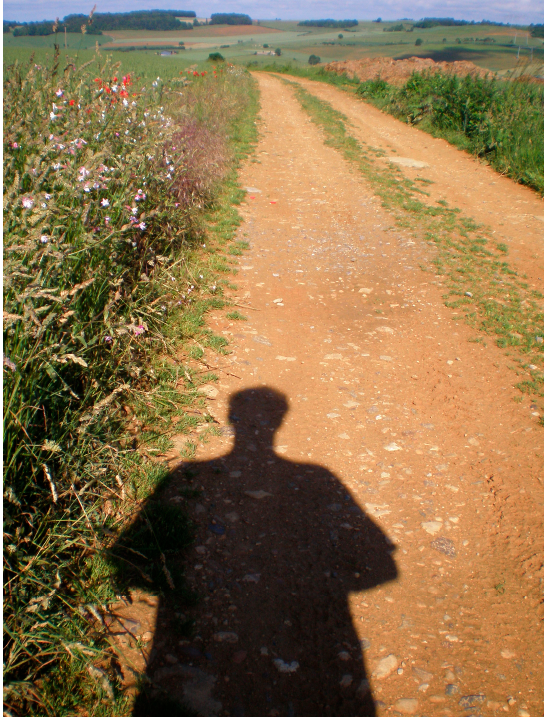
Figure 2. Author Thorsten H. Ecke walking on Rimbaud’s routes close to Charleville in France.